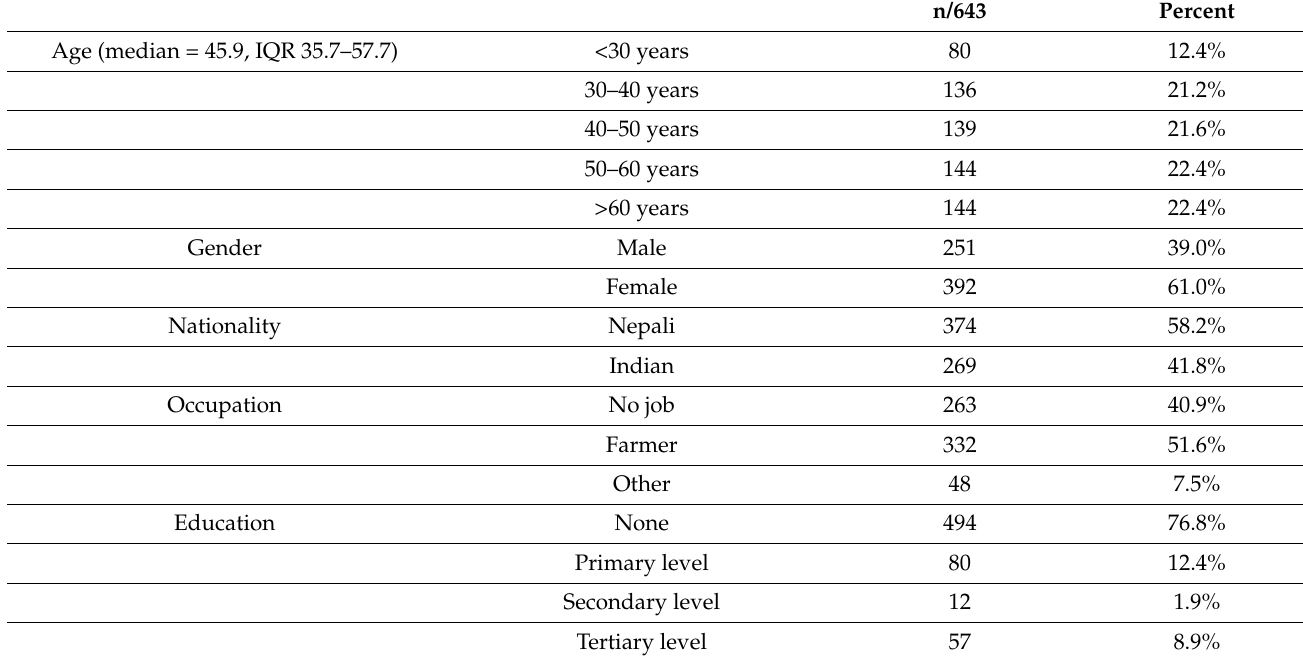
Table 1. Demographic characteristics and clinical history of study